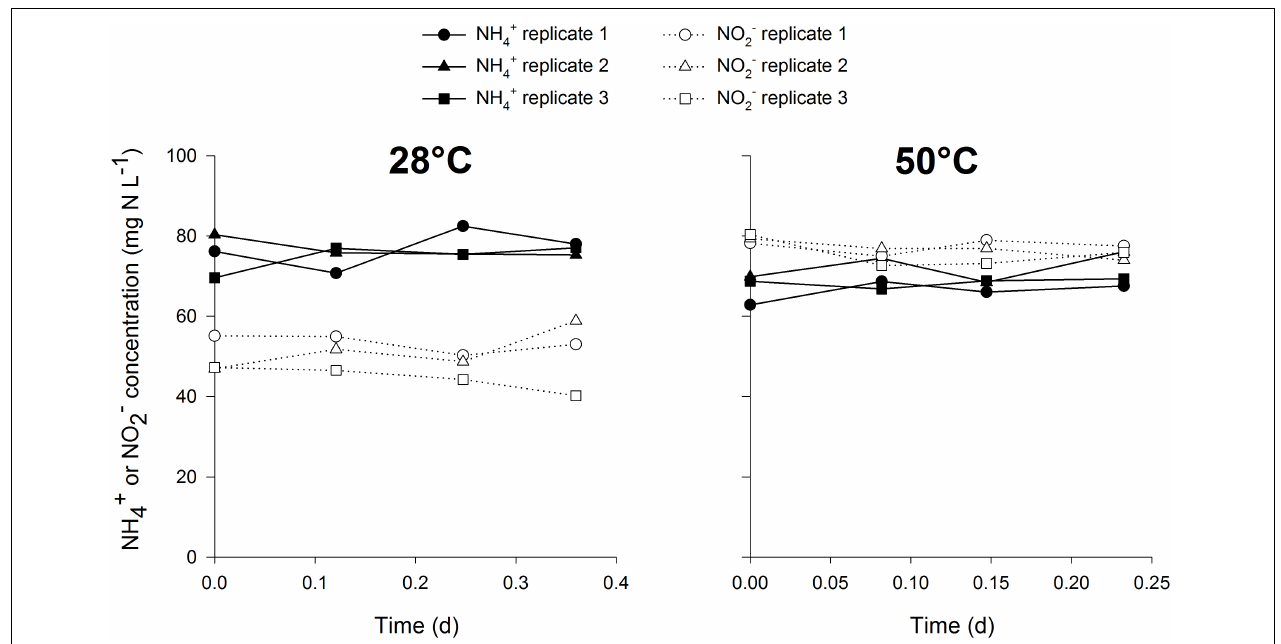
FIGURE 1 | Ammonium and nitrite concentrations in the closed serum flasks ( n = 3) at 28 ◦ C (left) and 50 ◦ C (right) during the control activity measurements in which nitrification was inhibited.